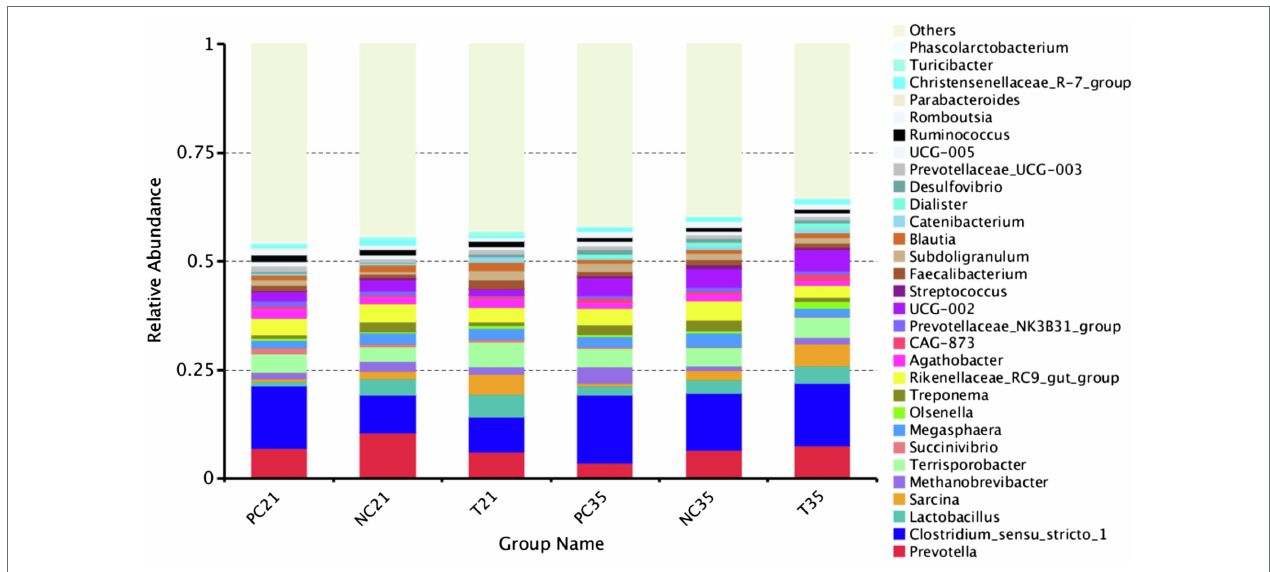
FIGURE 6 | Effects of Z. Tk and ZnO on the composition of gut microbiota at the genus level in three groups of piglets on days 21 and 35. Each of the nine samples is selected from each of the three groups of piglets, i.e., the positive control (PC), the negative control (NC), and the test groups, on days 21 and 35,